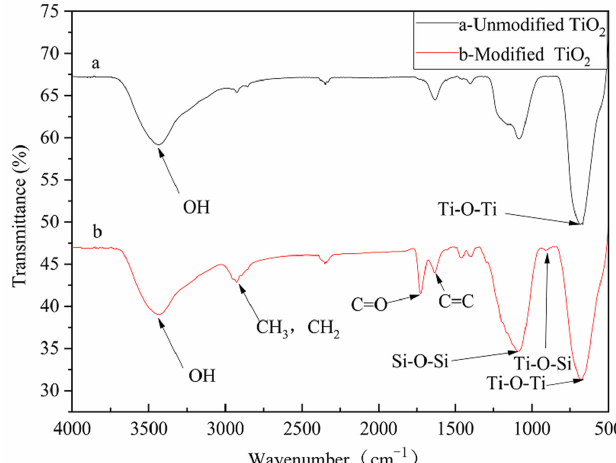
Figure 1. FT-IR results of unmodified TiO 2 and modified TiO 2 .